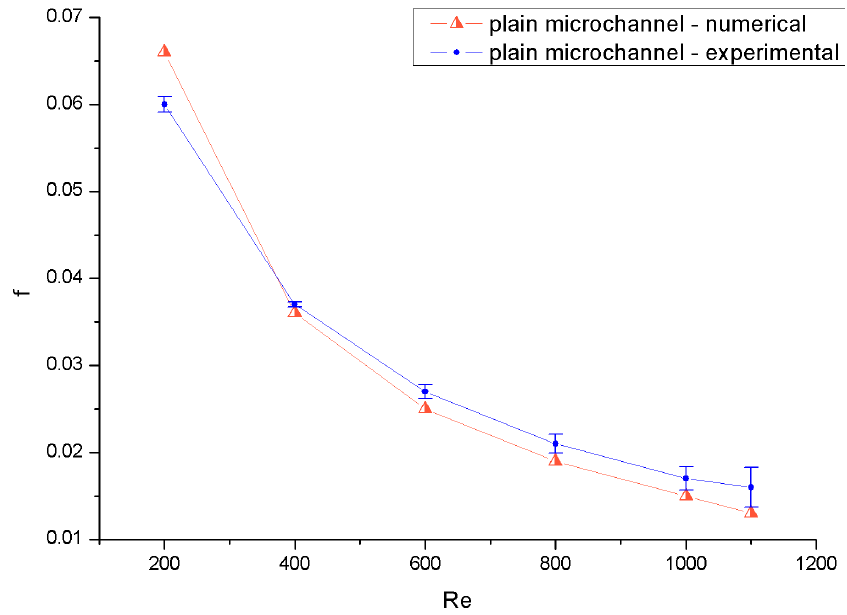
Figure 5. Comparison of friction factor values from the present numerical simulation and the experimental results of Liu et al. [25]. Table 3. Grid independence test results at Re = 800.